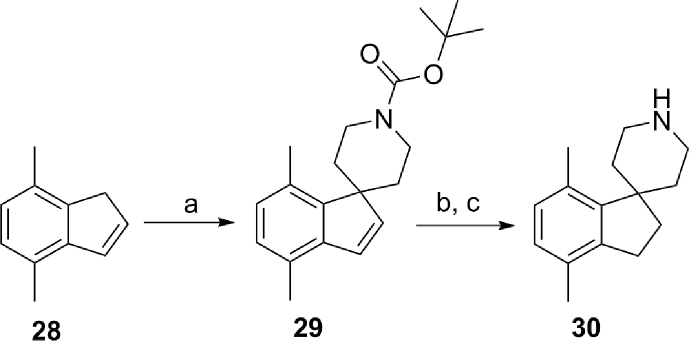
aReagents and conditions: (a) (i) LiN(SiMe3)2 (1 M solution in THF), THF, 0 °C, 45 min, (ii) tert-butyl bis(2-chloroethyl)carbamate, 0 °C, 2 h; (b) 10% Pd/C, EtOH, H2, room temp, 2 h; (c) 4 M HCl in dioxane, room temp, 2 h.